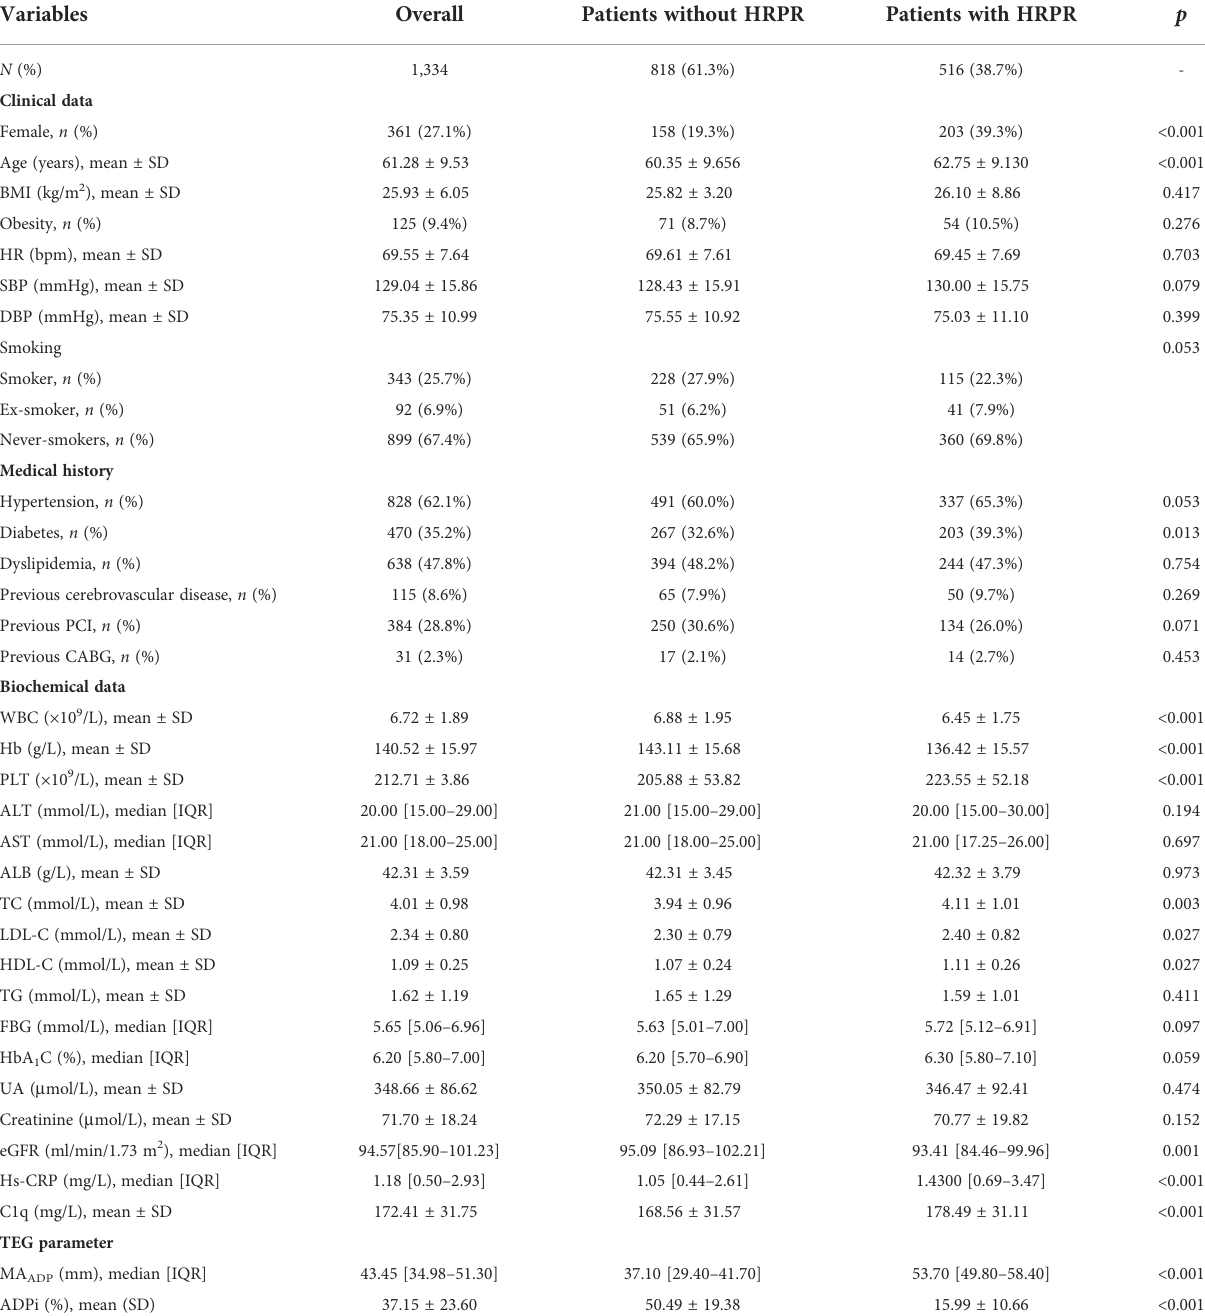
TABLE 1 Baseline characteristics in patients with and without HRPR.